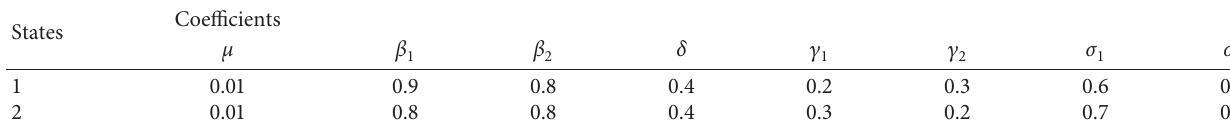
( t ) in red, I ( t ) in black, R ( t ) in green, and r ( t ) in brown in Example 1. 1 2 Table 2: Parameter values used in numerical simulations.